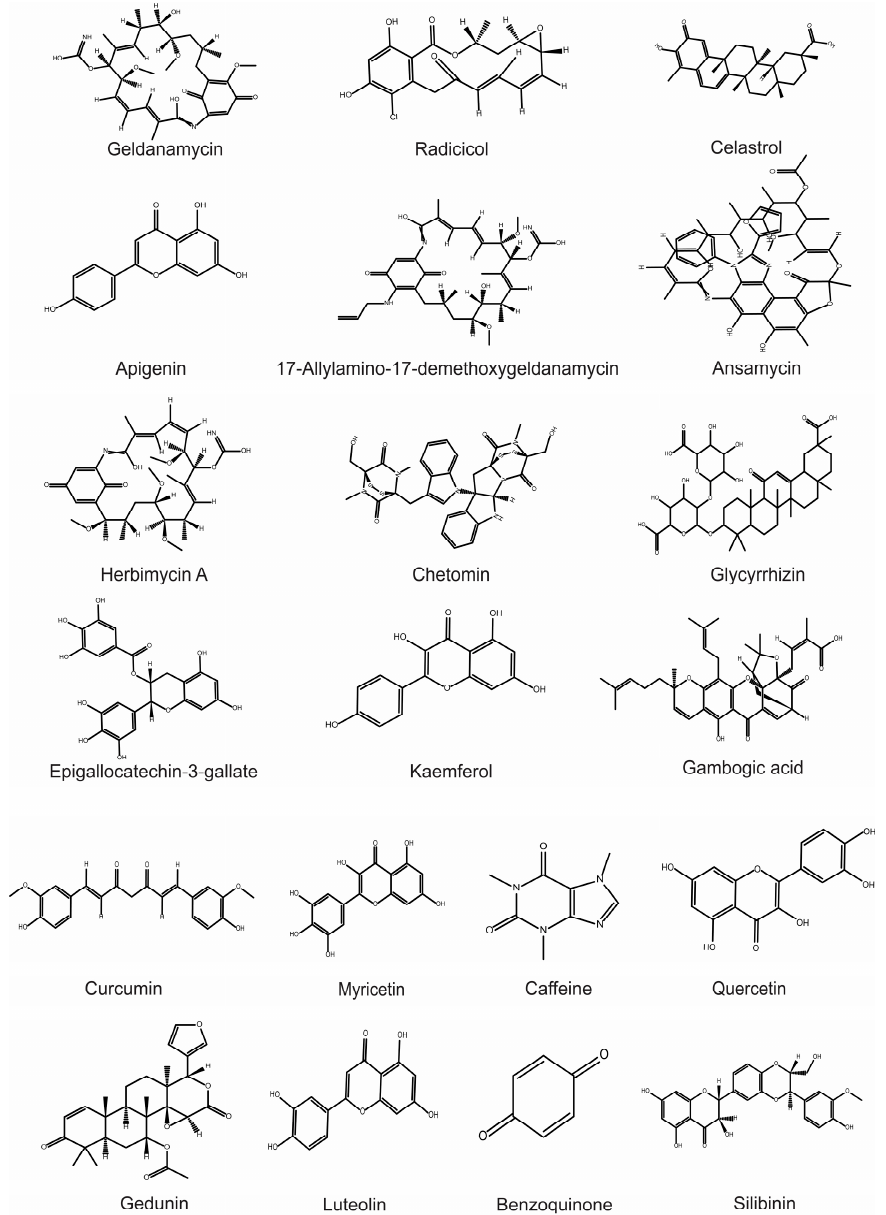
Figure 4. The chemical structures of naturally occurring Hsp90 inhibitors are pharmacologically active in GBM and neurodegeneration.